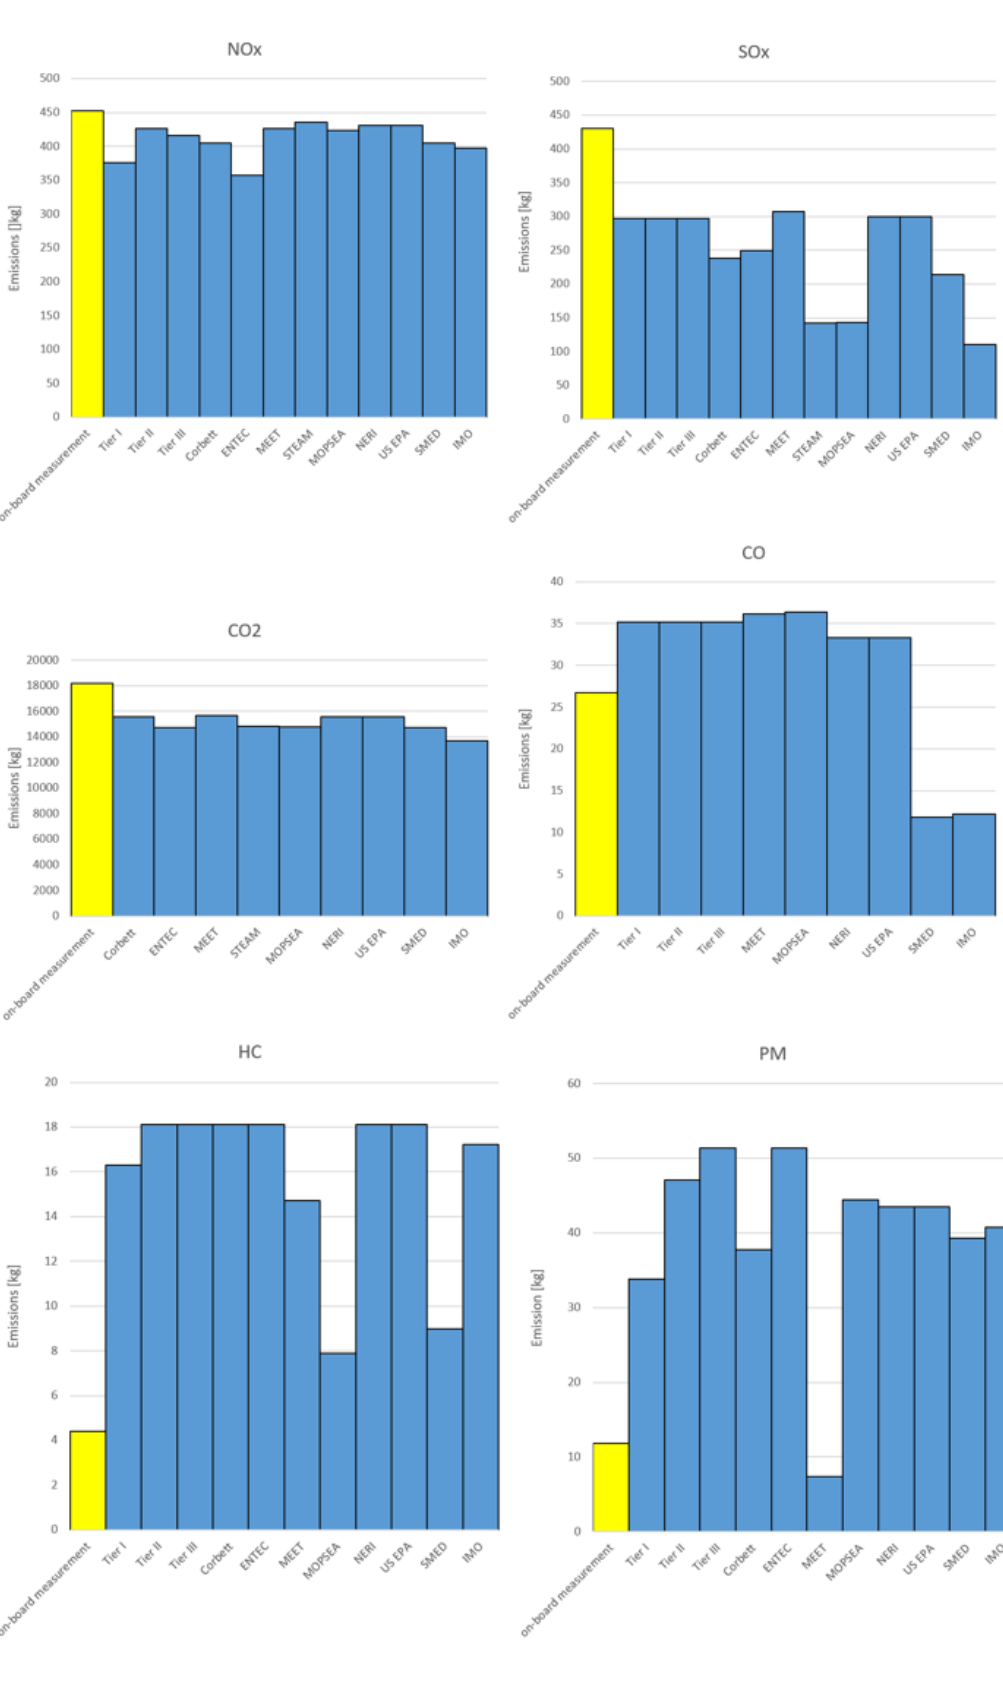
Figure 5. Total emission amounts’ measurement and inventory prediction when cruising for the main